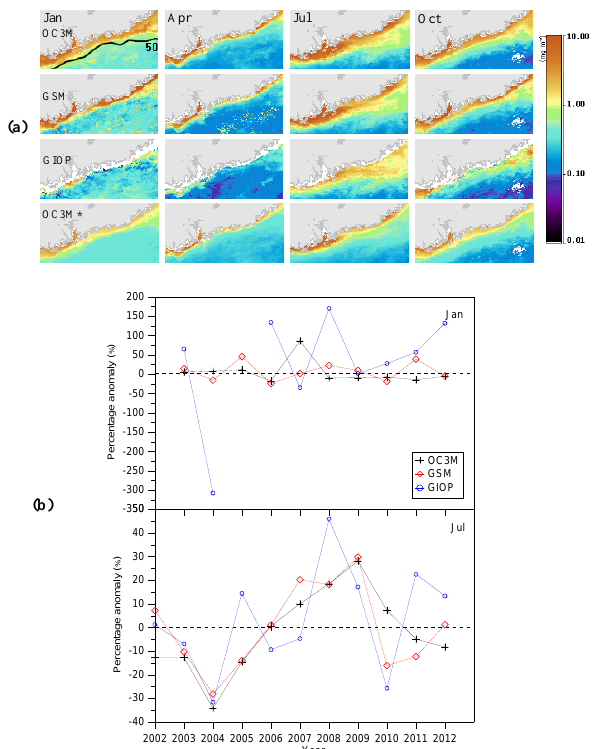
Fig. 8. (a) Monthly climatology of MODIS Chl in the vicinity of the Pearl River estuary in January, April, July and October. The isobath of 50 m is annotated on the January image of C_OC3M; (b) MODIS Chl anomaly (in percentage) in January and July of 2002–2012 for the nearshore waters of the Pearl River estuary (depth < 50m).